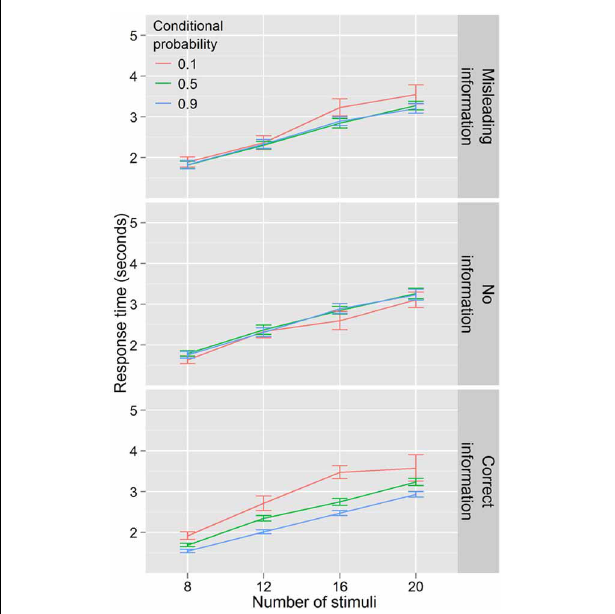
FIGURE 7 | Response times by distractor number for Experiment 4. Conditional probability modulates search efficiency only when participants have explicit knowledge.